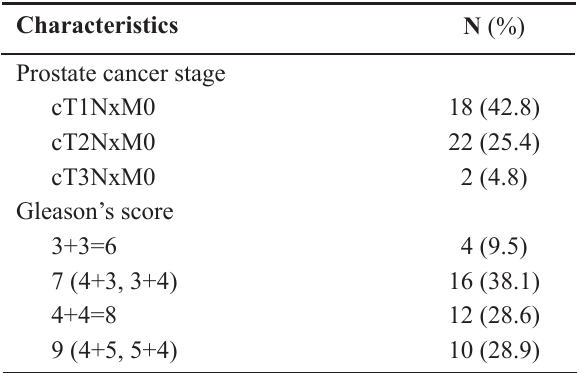
Table 2 – Basic characteristics of group I (prostate cancer